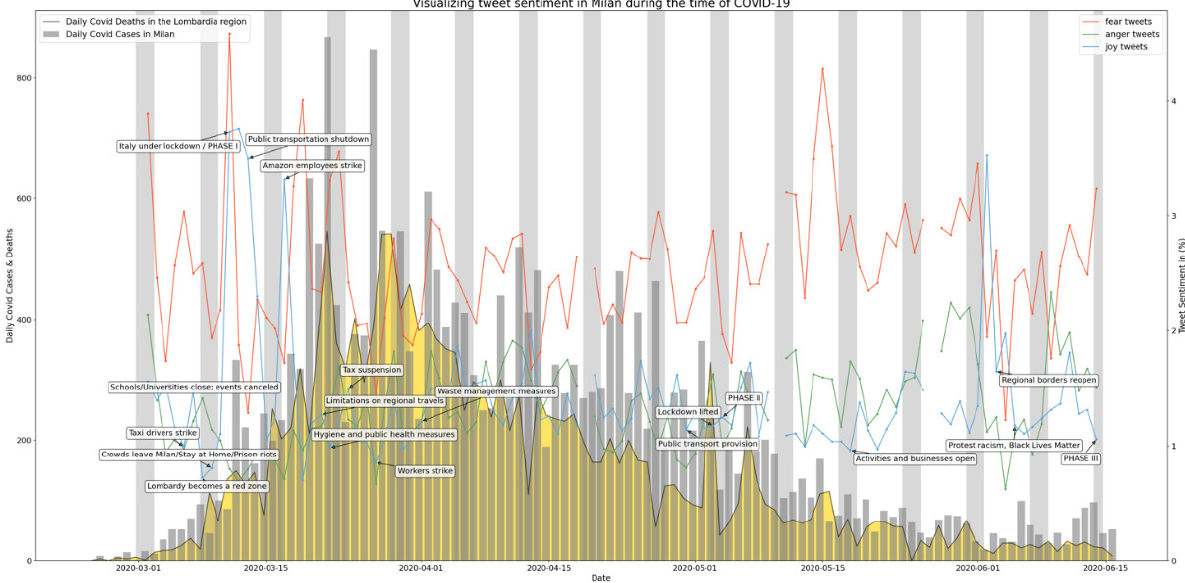
Figure A1. Visualizing Twitter sentiment in Milan during the time of COVID-19. With regard to fear, the highest frequencies of tweets related to fear were found in the month of May with 2.84% of the total collected tweets when compared to March with 2.42%, April with 2.40%, and June with 2.39%, respectively. Milan Twitter users displayed a total of 2.49% tweet frequency expressing fear. Fear may reflect the beginning of Phase II, which eased many of the measures intended to contain the virus